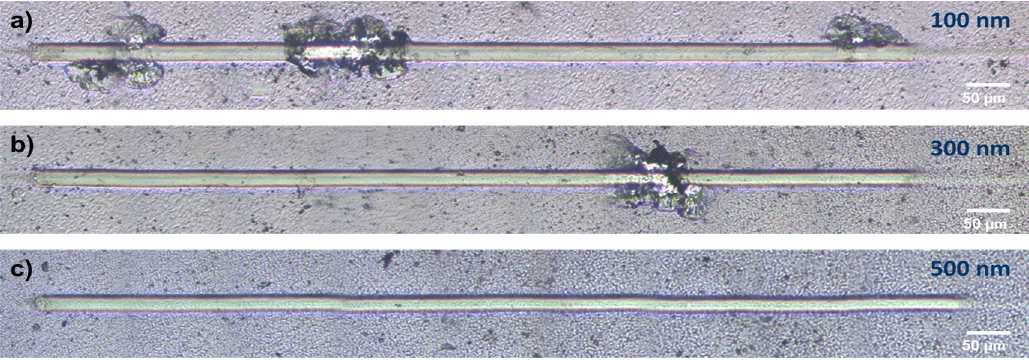
Figure 10. Microscopic images of the wear track after 15th pass at a repetitive load of 1.5 N, for coatings with interlayer thickness ( a ) 100 nm, ( b ) 300 nm, and ( c ) 500 nm.